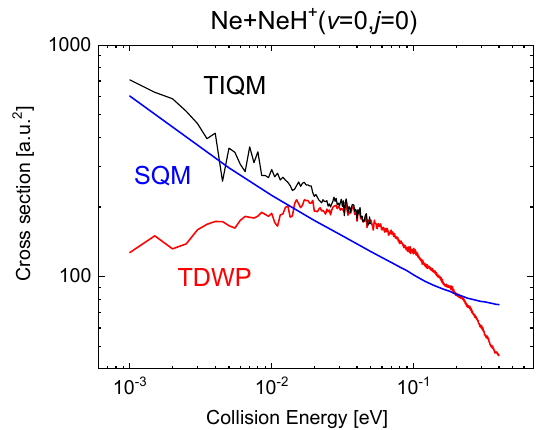
Figure 15. Cross sections as a function of the collision energy (in eV) for the Ne + NeH + → Ne + NeH + calculated with the TIQM (black line), TDWP (red line), and SQM (blue line) methods in [70]. These quantitative discrepancies seen in the ICSs have also a consequence in the cor- responding rate constants. In Figure 16, values of k ( T ) obtained with the TIQM and SQM cross sections of Equation (15) are compared between 50 K and 900 K. The TIQM rate constants are always larger than the statistical counterparts and, for example, at T = 900 K, k TIQM ( T ) = 4.46 × 10 − 10 cm − 3 s − 1 , whereas the SQM yields a value of 3.82 × 10 − 10 cm − 3 s − 1 . The constant Langevin value of 4.63 × 10 − 10 cm − 3 s − 1 , also included in Figure 16 for com- parison, remain